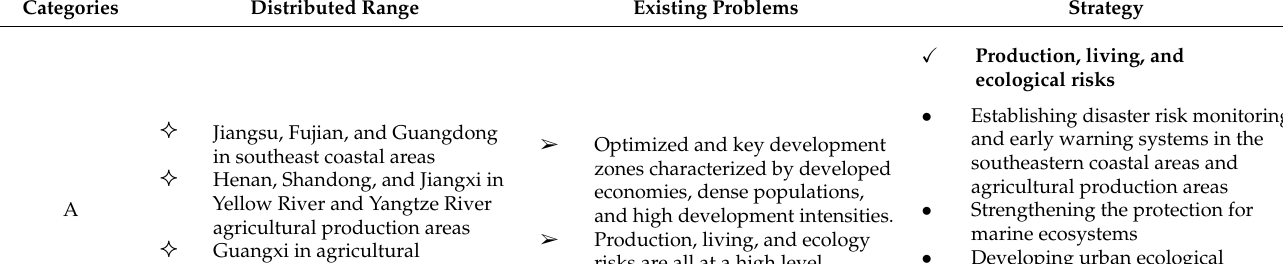
Table 3. Strategy to cope with PLE risk under climate change scenario.